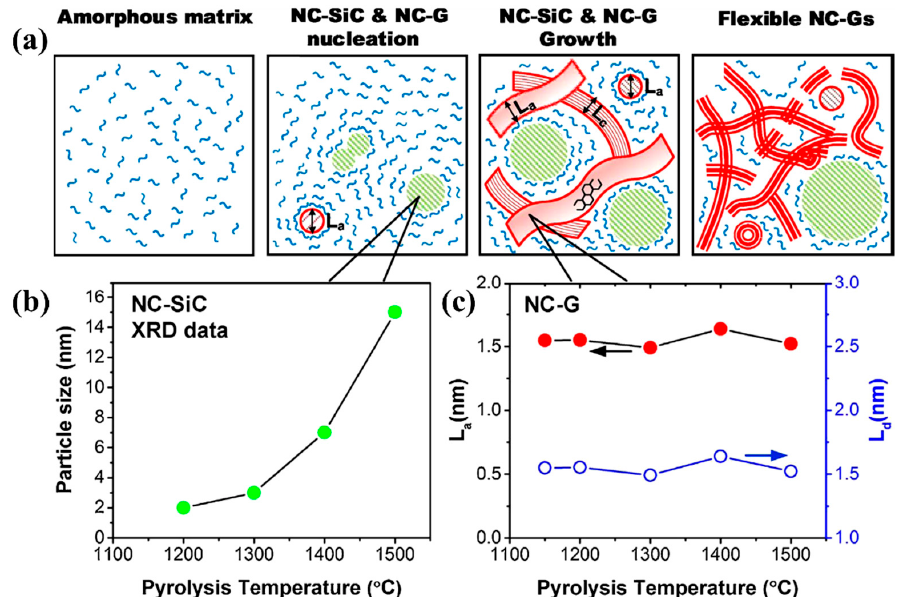
Figure 2. ( a ) Schematics of a detailed model describing the temperature-dependent evolution of nanodomains comprised of SiC, free carbon, and residual amorphous matrix in polymer-derived C-enriched SiC ceramics. ( b ) the average NC–SiC particle size varied with temperature, from 2 nm (1200 °C) to 15 nm (1500 °C). ( c ) the in-plane crystallite diameters (L a ) of the NC-G phase and the average defect distances of a single graphene sheet (L d ) grow trend varied with temperature, both remained nearly constant [54].